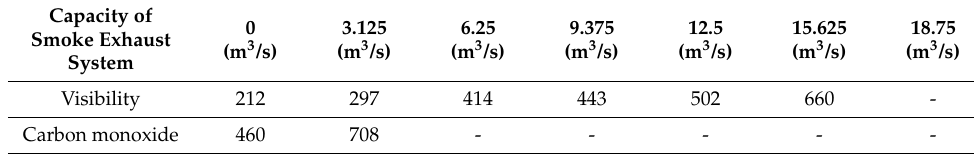
Table 4. Available safe egress time (ASET).